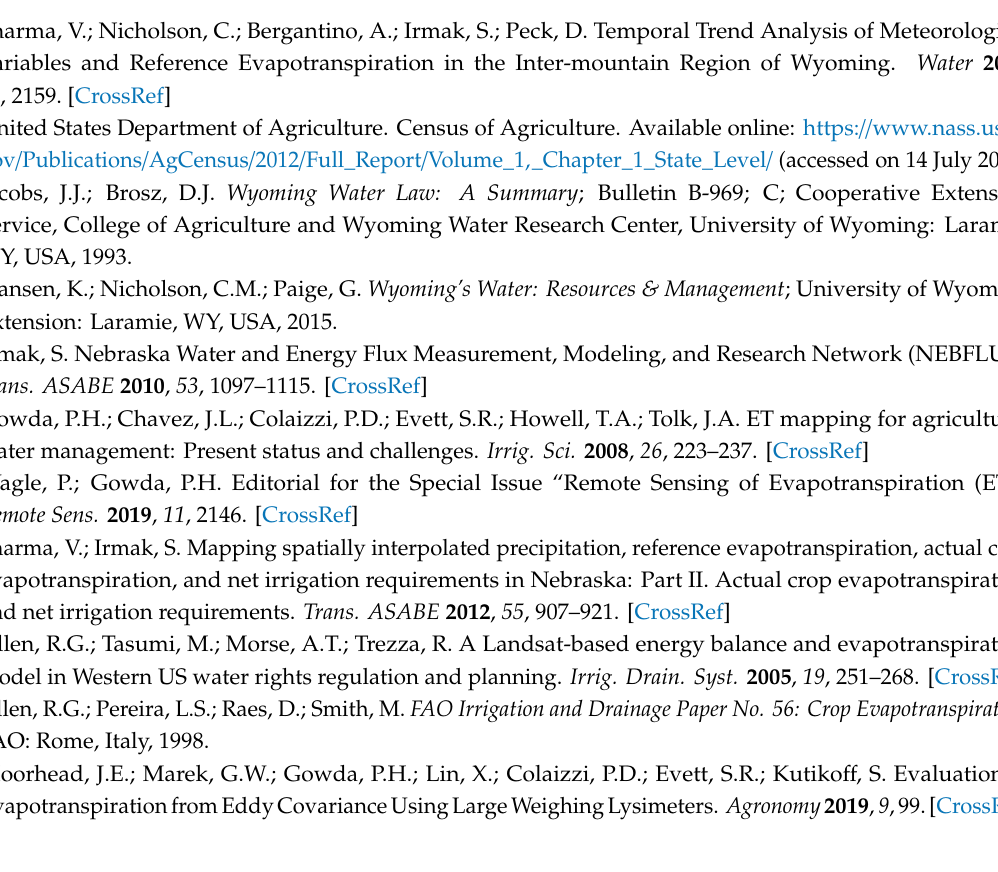
Table S1: Average seasonal crop evapotranspiration ET c , seasonal precipitation (P), and Irrigation contribution to ET c (ET c -P) for four major crops i.e., Sugar beet, Dry bean, Alfalfa, and Maize within Cody Canal Irrigation District for 2017 and 2018. Table S2: Average seasonal crop evapotranspiration ET c , seasonal precipitation (P), and Irrigation contribution to ET c (ET c -P) for four major crops i.e., Sugar beet, Dry bean, Alfalfa, and Maize within Deaver Irrigation District for 2017 and 2018. Table S3: Average seasonal crop evapotranspiration ET c , seasonal precipitation (P), and Irrigation contribution to ET c (ET c -P) for four major crops i.e., Sugar beet, Dry bean, Alfalfa, and Maize within Greybull Valley Irrigation District for 2017 and 2018. Table S4: Average seasonal crop evapotranspiration ET c , seasonal precipitation (P), and Irrigation contribution to ET c (ET c -P) for our major crops i.e., Sugar beet, Dry bean, Alfalfa, and Maize within Heart Mountain Irrigation District for 2017 and 2018. Table S5: Average seasonal crop evapotranspiration ET c , seasonal precipitation (P), and Irrigation contribution to ET c (ET c -P) for four major crops i.e., Sugar beet, Dry bean, Alfalfa, and Maize within Hunt & Godfrey Irrigation District for 2017 and 2018. Table S6: Average seasonal crop evapotranspiration ET c , seasonal precipitation (P), and Irrigation contribution to ET c (ET c -P) for four major crops i.e., Sugar beet, Dry bean, Alfalfa, and Maize within Lovell Irrigation District for 2017 and 2018. Table S7: Average seasonal crop evapotranspiration ET c , seasonal precipitation (P), and Irrigation contribution to ET c (ET c -P) for four major crops i.e., Sugar beet, Dry bean, Alfalfa, and Maize within Shoshone Irrigation District for 2017 and 2018. Table S8: Average seasonal crop evapotranspiration ET c , seasonal precipitation (P), and Irrigation contribution to ET c (ET c -P) for four major crops i.e., Sugar beet, Dry bean, Alfalfa, and Maize within Sidon Irrigation District for 2017 and 2018. Table S9: Average seasonal crop evapotranspiration ET c , seasonal precipitation (P), and Irrigation contribution to ET c (ET c -P) for four major crops i.e., Sugar beet, Dry bean, Alfalfa, and Maize within Will Wood Irrigation District